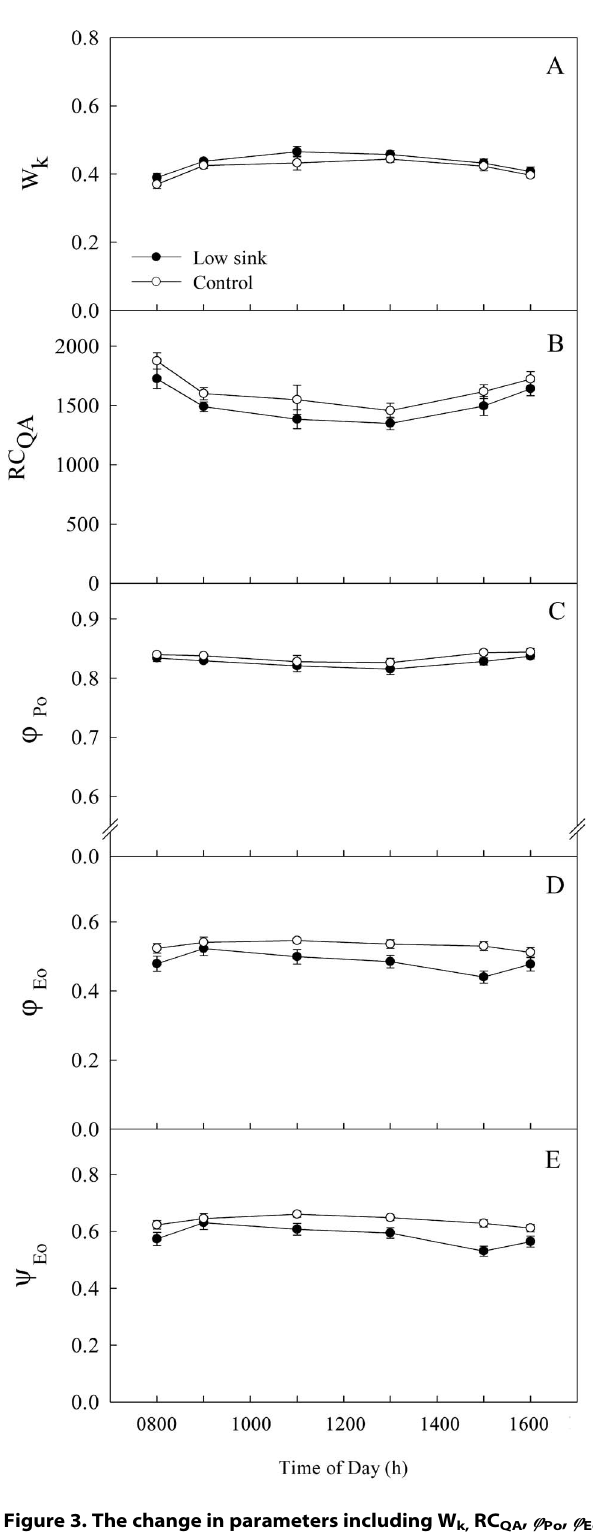
Figure 3. The change in parameters including W k, RC QA , Q Po , Q Eo and y Eo involved in electron transport chain of PSII in bean ( V. faba L.) source leaves on the 1 st day after removing the sink of roots and pods. Each value represents the mean of five replicates, and error bars represent 6 S.E. The asterisks *, ** and *** indicate significant difference at P , 0.05, 0.01 and 0.001 between the control and treatment, respectively.